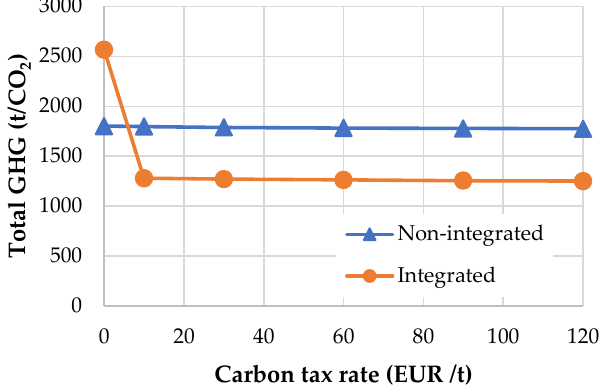
Figure 2. Total CO 2 emissions at different values of the CO 2 tax rate. The percentage of the stream that is purged at different CO 2 emission tax rates is shown in Figure 3. A larger fraction of the purge occurs in the nonintegrated process. The difference between the purge fraction in the nonintegrated and integrated process at higher CO 2 tax rates is about 5 percentage points. At lower CO 2 tax rates, the difference is smaller due to the higher emissions caused by choosing a cheaper raw material.